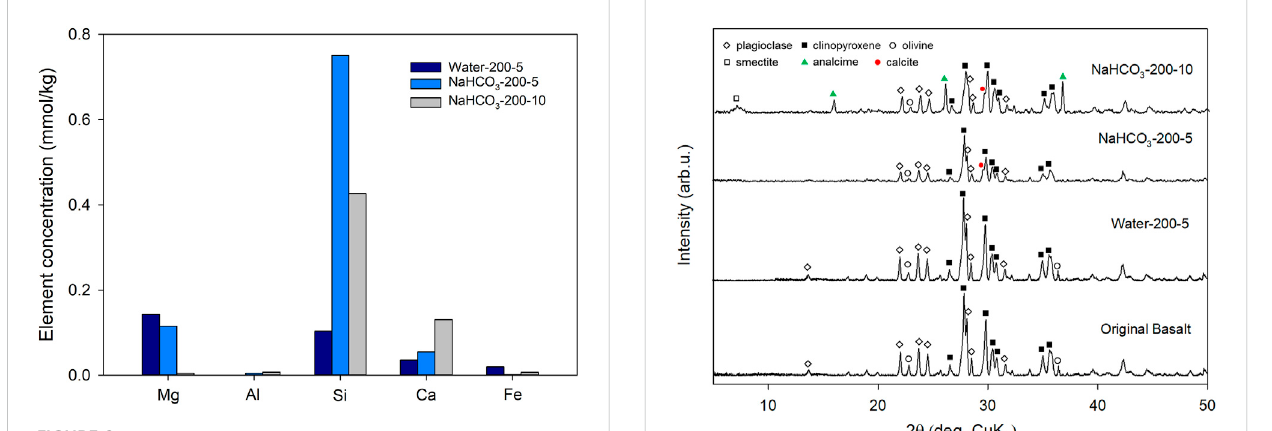
FIGURE 2 Concentrationsofmainelements(Mg,Al,Si,Ca,andFe)inMilli-Q water after reacting with basalt for 5 days (Run 1), and in NaHCO 3 solutions, afterreactingwithbasaltfor 5 days(Run2)and10 days (Run 5) at 200 ° C and water saturated pressure. “ NaHCO 3 -200-5 ” refers to the use of 0.5 mol/L NaHCO 3 solution at 200 ° C for 5 days.